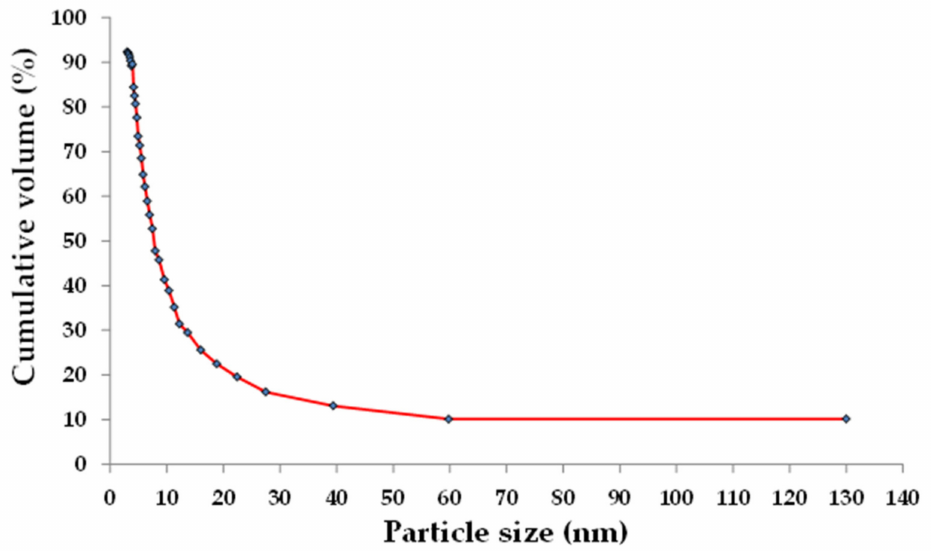
Figure 2. Particle size distribution of Neem Seed Husk Ash